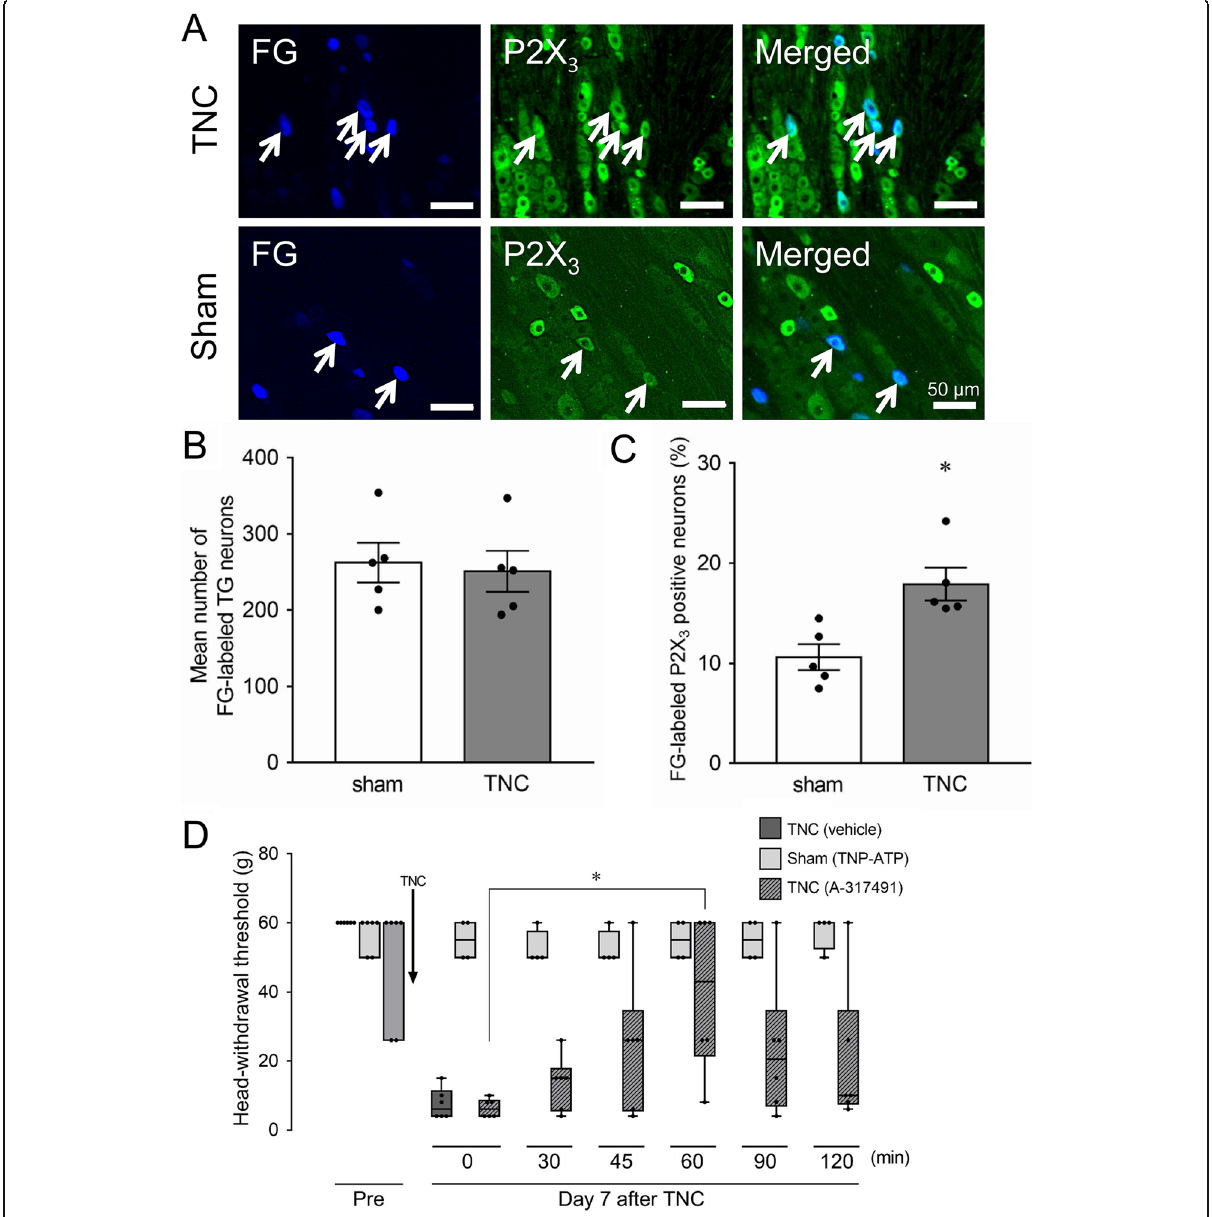
Fig. 4 Changes in P2X 3 R expression in TG neurons innervating whisker pad skin and the involvement of P2X 3 R signaling in TG neurons in orofacial mechanical hypersensitivity on day 7 following TNC. a Photomicrograph of FG-labeled P2X 3 IR TG neurons following the TNC or sham procedure. Arrows indicate FG-labeled P2X 3 IR TG neurons. Scale bar: 100 μ m. b Mean number of FG-labeled TG neurons ipsilateral to the TNC or sham procedure ( n = 5 in each). c The frequency of FG-labeled P2X 3 -IR TG neurons ipsilateral to the TNC or sham procedure. * p < 0.05 vs. sham. ( n = 5 in each, student ’ s t -test). d The time course of changes in the MHWT by subcutaneous A317491 or TNP-ATP administration on day 7 following the TNC or sham procedure. Data are presented as median, interquartile range (25 – 75 %), and maximum and minimum values. * p < 0.05. ( n = 4 – 6; Kruskal-Wallis followed by Dunn ’ s multiple comparisons